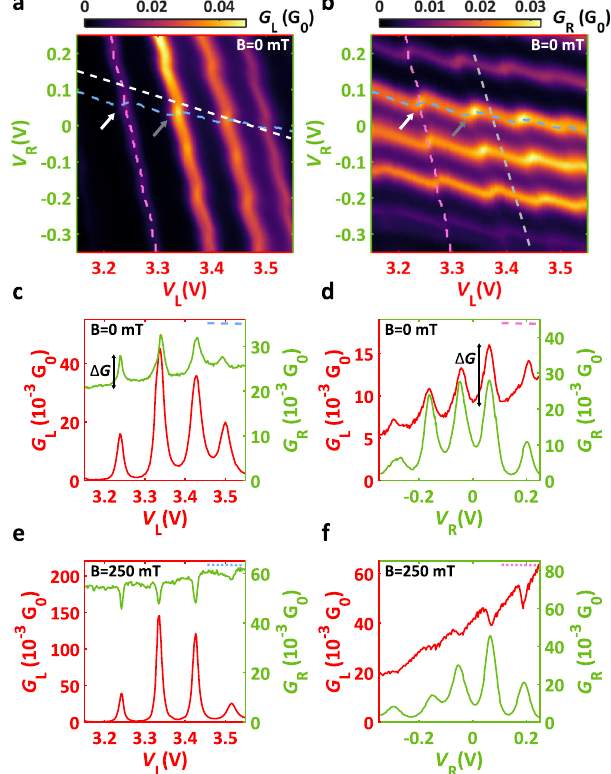
Fig. 3 CPS validation. a , b Same gate stability maps as in Fig. 2a, b, but in the superconducting state. The white and gray arrows show the spots with the maximal splitting ef fi ciency and maximal visibility of the non-local signal, respectively. c Conductance along a selected resonance of the right QD indicated by the blue dashed line in panels ( a , b ). There is a strong positive correlation between G L and G R . d Similar cut to panel ( c ), but along a resonance of the left QD shown by the pink dashed line in panels ( a , b ). The peaks at = 3.24 V match the one at V = 0.07 V in panel ( c ) with the same V L R amplitude of Δ G . e , f Normal state data of the corresponding cuts in panels ( c , d ) (taken along the pink and blue dotted lines in Fig. 2a, b). Once the superconductivity is suppressed by external magnetic fi eld, negative correlations overtake the non-local peaks arising from the non-negligible U LR